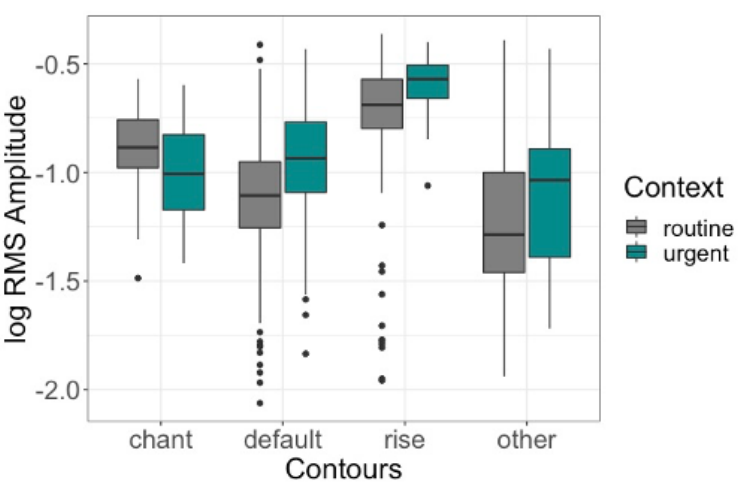
Figure 17. RMS amplitude in the routine and urgent context across different calling melodies in CF.